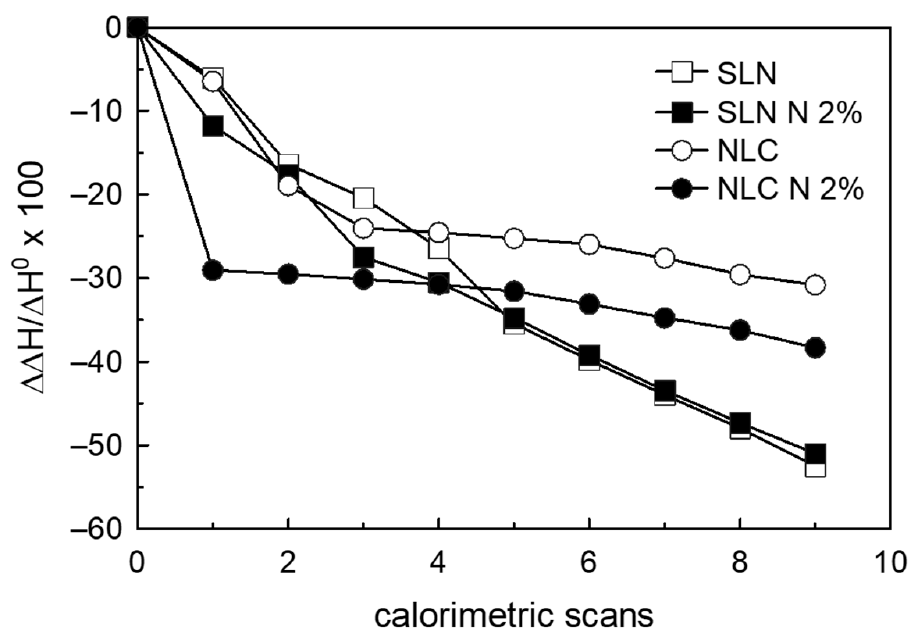
Figure 8. Transition enthalpy variation of MLV left in contact with unloaded SLN, 2% Naringenin- loaded SLN, unloaded NLC, and 2% Naringenin-loaded NLC, as a function of the calorimetric scans. The transition enthalpy variation is reported as ∆∆ H/ ∆ H 0 ( ∆∆ H = ∆ H − ∆ H 0 , where ∆ H is the transition enthalpy variation of the MLV left in contact with SLN or NLC, and ∆ H 0 is the transition enthalpy variation of MLV).